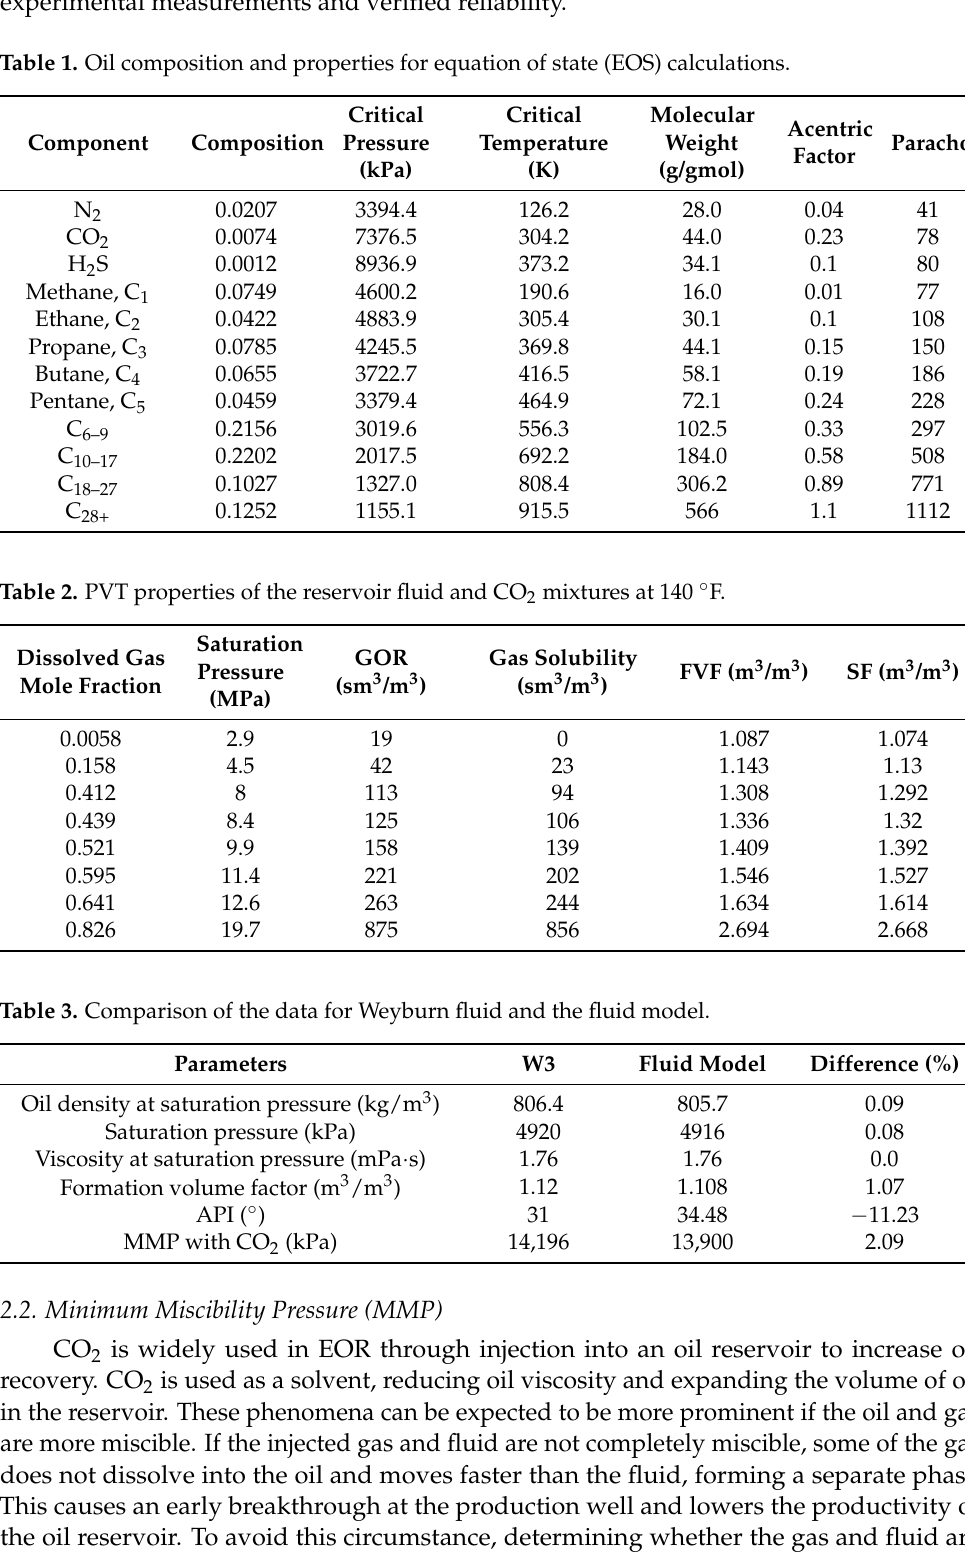
Table 1. Oil composition and properties for equation of state (EOS) calculations.